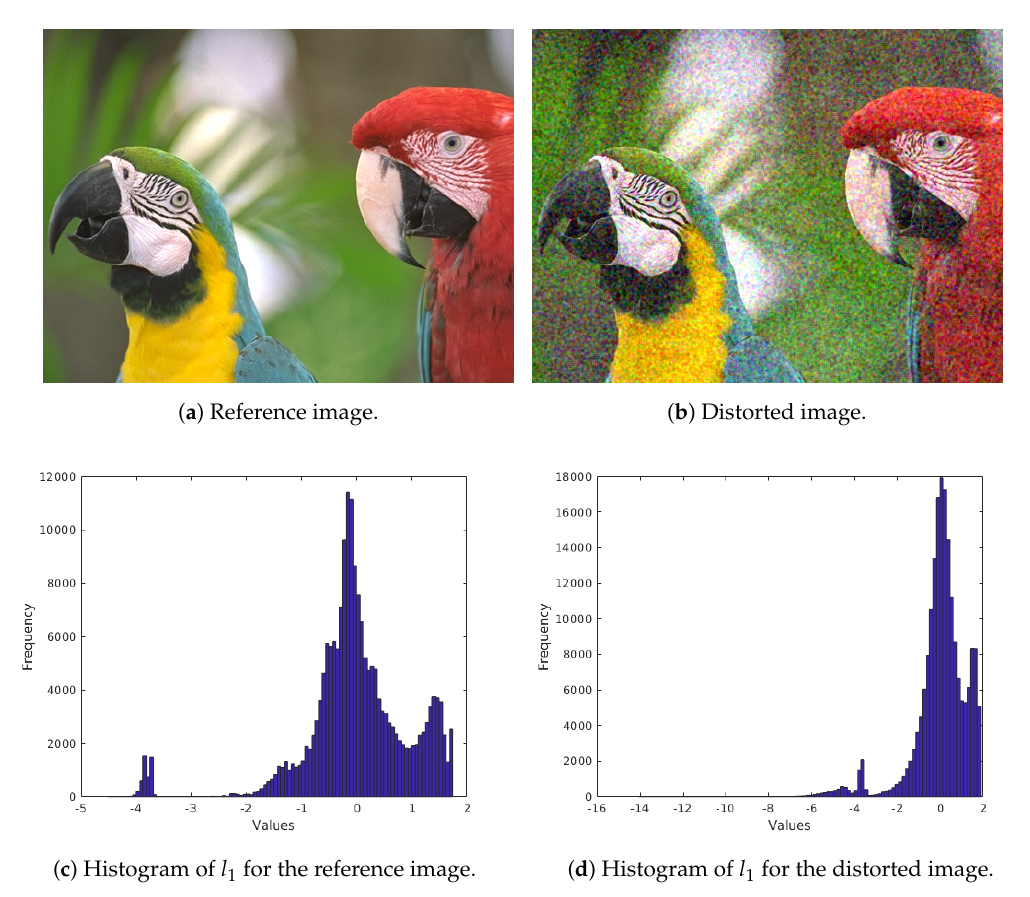
Figure 3. Illustration of l 1 values distribution in a reference and a distorted image from TID2013 [39]